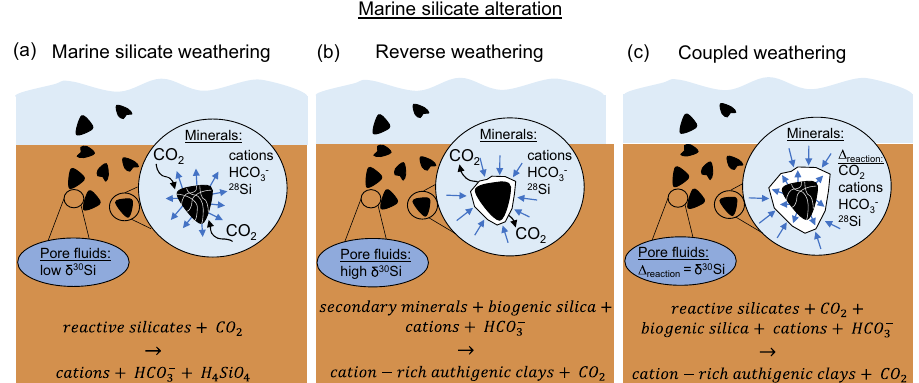
Fig. 1 | Schematic of marine silicate alteration reactions. a Marine silicate weathering, releasing cations and alkalinity (here HCO (cid:1) 3 ) to pore fl uids, b reverse weathering,consumingcationsandalkalinity,and c coupledweathering,wherethe net CO 2 and alkalinity turnover depends on the dominance of mineral dissolution versus precipitation. Black symbols represent terrigenous minerals subject